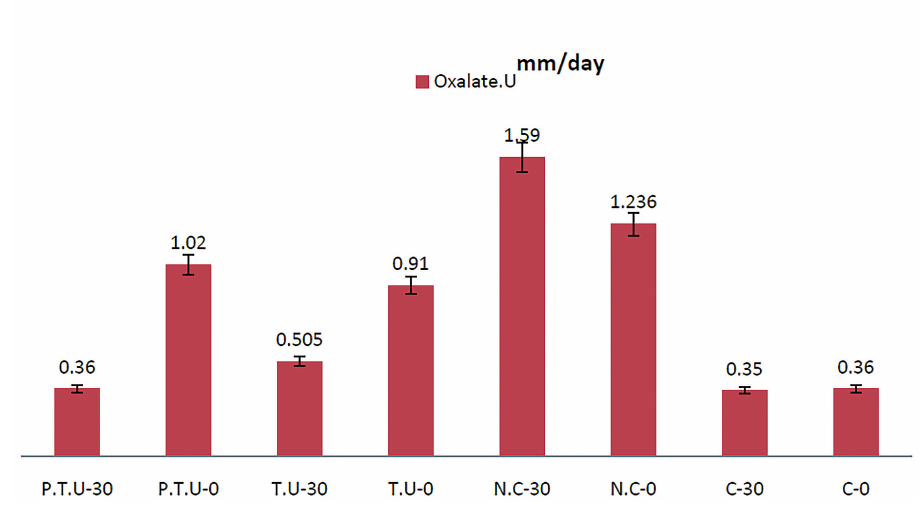
Figure 1 - Urinary Oxalate level in all groups in 0- and -30